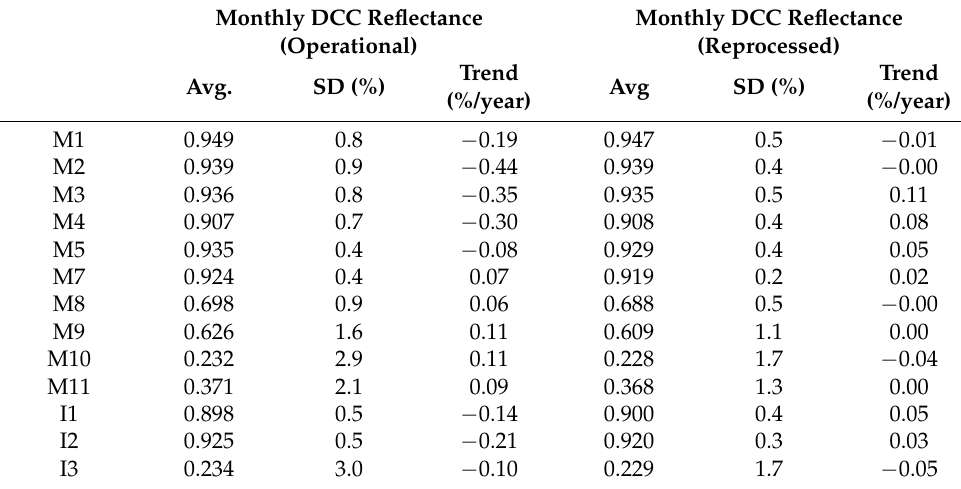
Table 4. Statistics of monthly DCC time series for the operational and reprocessed Suomi NPP VIIRS